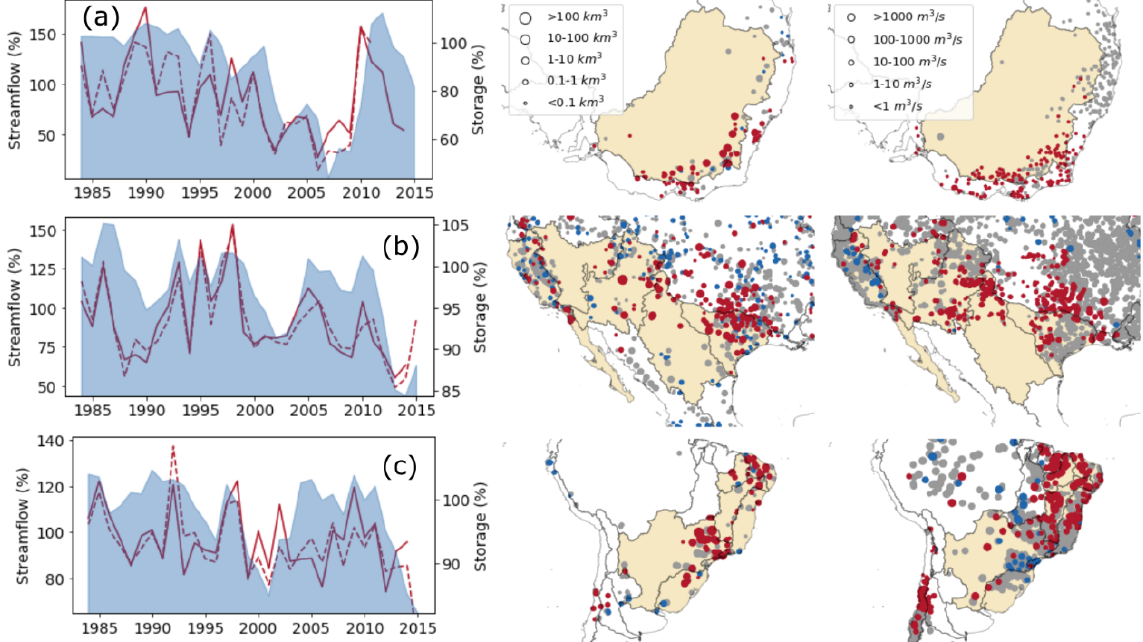
Figure 11. Time series (a–c) of annual combined storage (blue shaded) along with simulated (solid) and observed (dashed line) streamflow, indexed to the reference period 1984–1999, trends in storage (middle column panels), and observed streamflow (right column panels) during 1984–2015 ( p < 0 . 05; increasing: blue; no change: gray; declining: red). Shown are (top row panels) southeastern Australia, (second row panels) southwestern USA, and (third row panels)